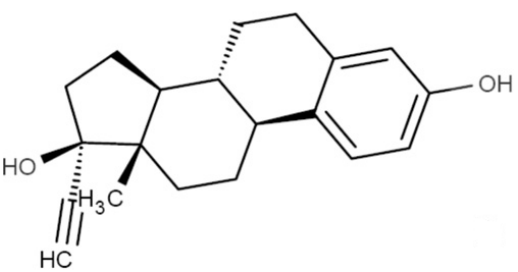
Figure 1. Chemical structures of the estrogenic compound 17-α-ethinyl estradiol (EE).